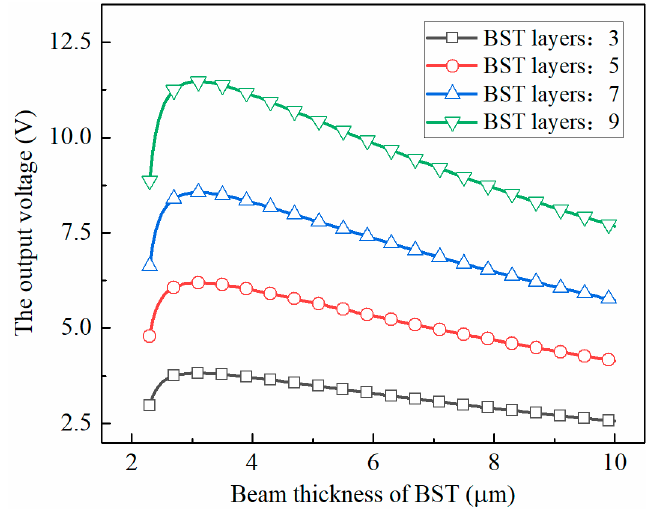
Figure 7. Output voltage of BST sensitive layer with different number of layers varying with the thickness of BST layer.